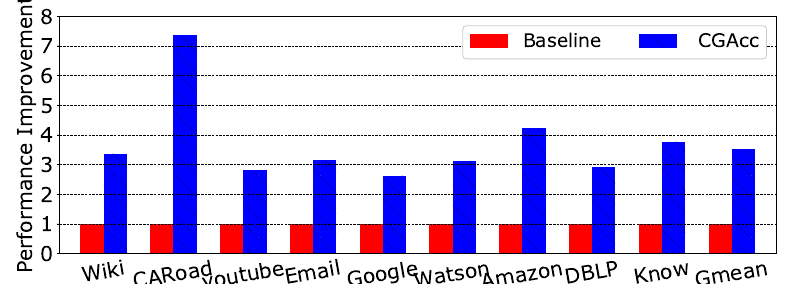
Figure 10. Comparison of the performance between baseline and CGAcc.